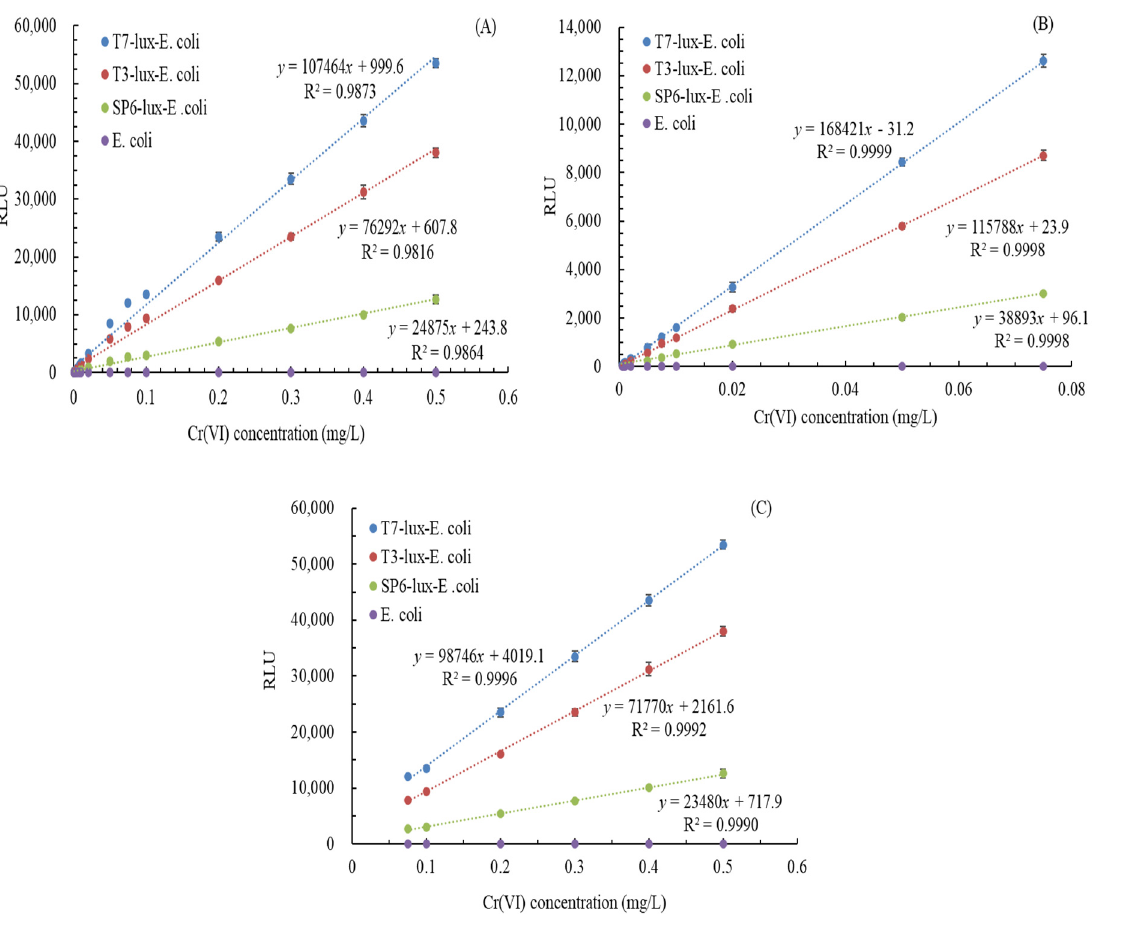
Figure 6. Relationship between Cr(VI) concentration [( A ) 0–0.5 mg/L, ( B ) 0–0.075 mg/L and ( C ) 0.075–0.5 mg/L] and luminescence intensities of three recombinant E. coli biosensors (cell source: the thawing frozen cells after 90-day cryogenic storage; initial cell concentration: 5 × 10 6 cfu/mL; culture media: modified TMM; operational condition: 37 ◦ C and 200 rpm; incubation time: 1.5 h for T7-lux- E. coli , 1 h for T3-lux- E. coli , and 0.5 h for SP6-lux- E. coli